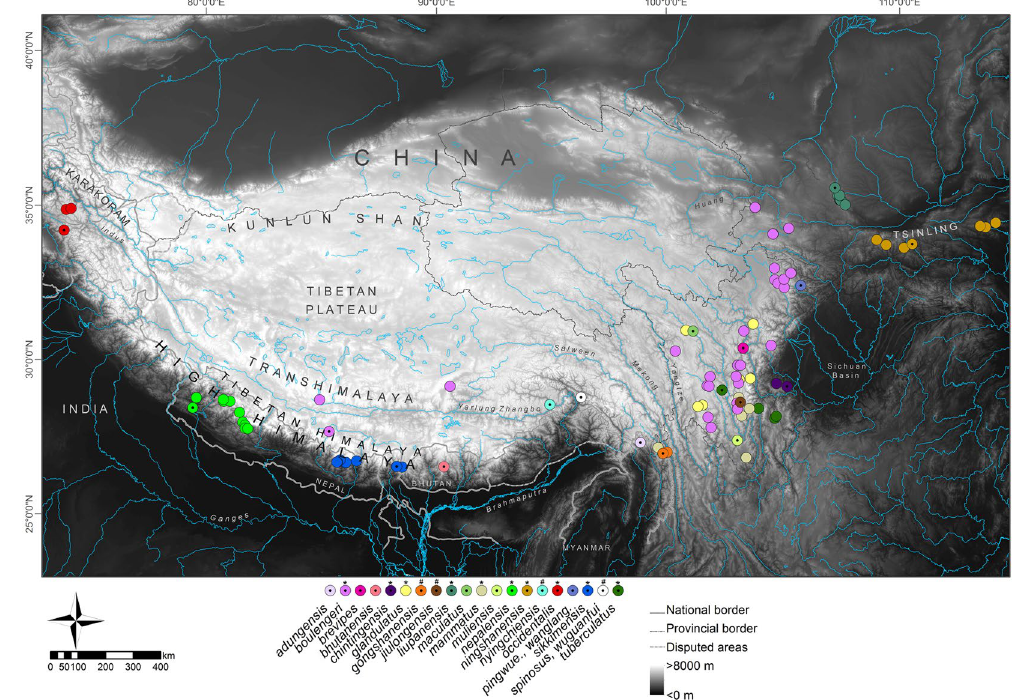
Figure 1. Map of High Asia. Shown are main parts of the Himalayan Tibetan mountain system and known records of Scutiger species. Only genetically verified records (coloured circles) and type localities (coloured circles with a dot in the middle) are used, including our samples. For S . bhutanensis , S . glandulatus and S . mammatus georeferencing of the type locality was not possible. For details and further records of S . occidentalis see Supplementary Information S3. Species included in the concatenated nuclear and/or mitochondrial as well as the co1 -dataset are marked with an asterisk. A hash key indicates species that were only represented by co1 data; pingwue . = pingwuensis ; wanglang . = wanglangensis . The map was created using ArcMap 10.3.1 (https://